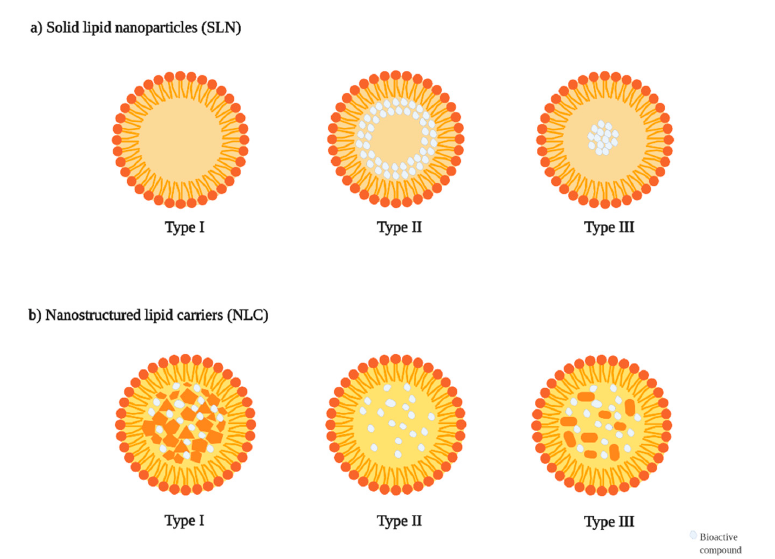
Figure 3. Different types of SLNs and NLCs. Type I SLN does not present any “drug” icon due to the homogeneity of the matrix; ( a ) Solid lipid nanoparticles (SLN); ( b ) Nanostructured lipid carriers (NLC).